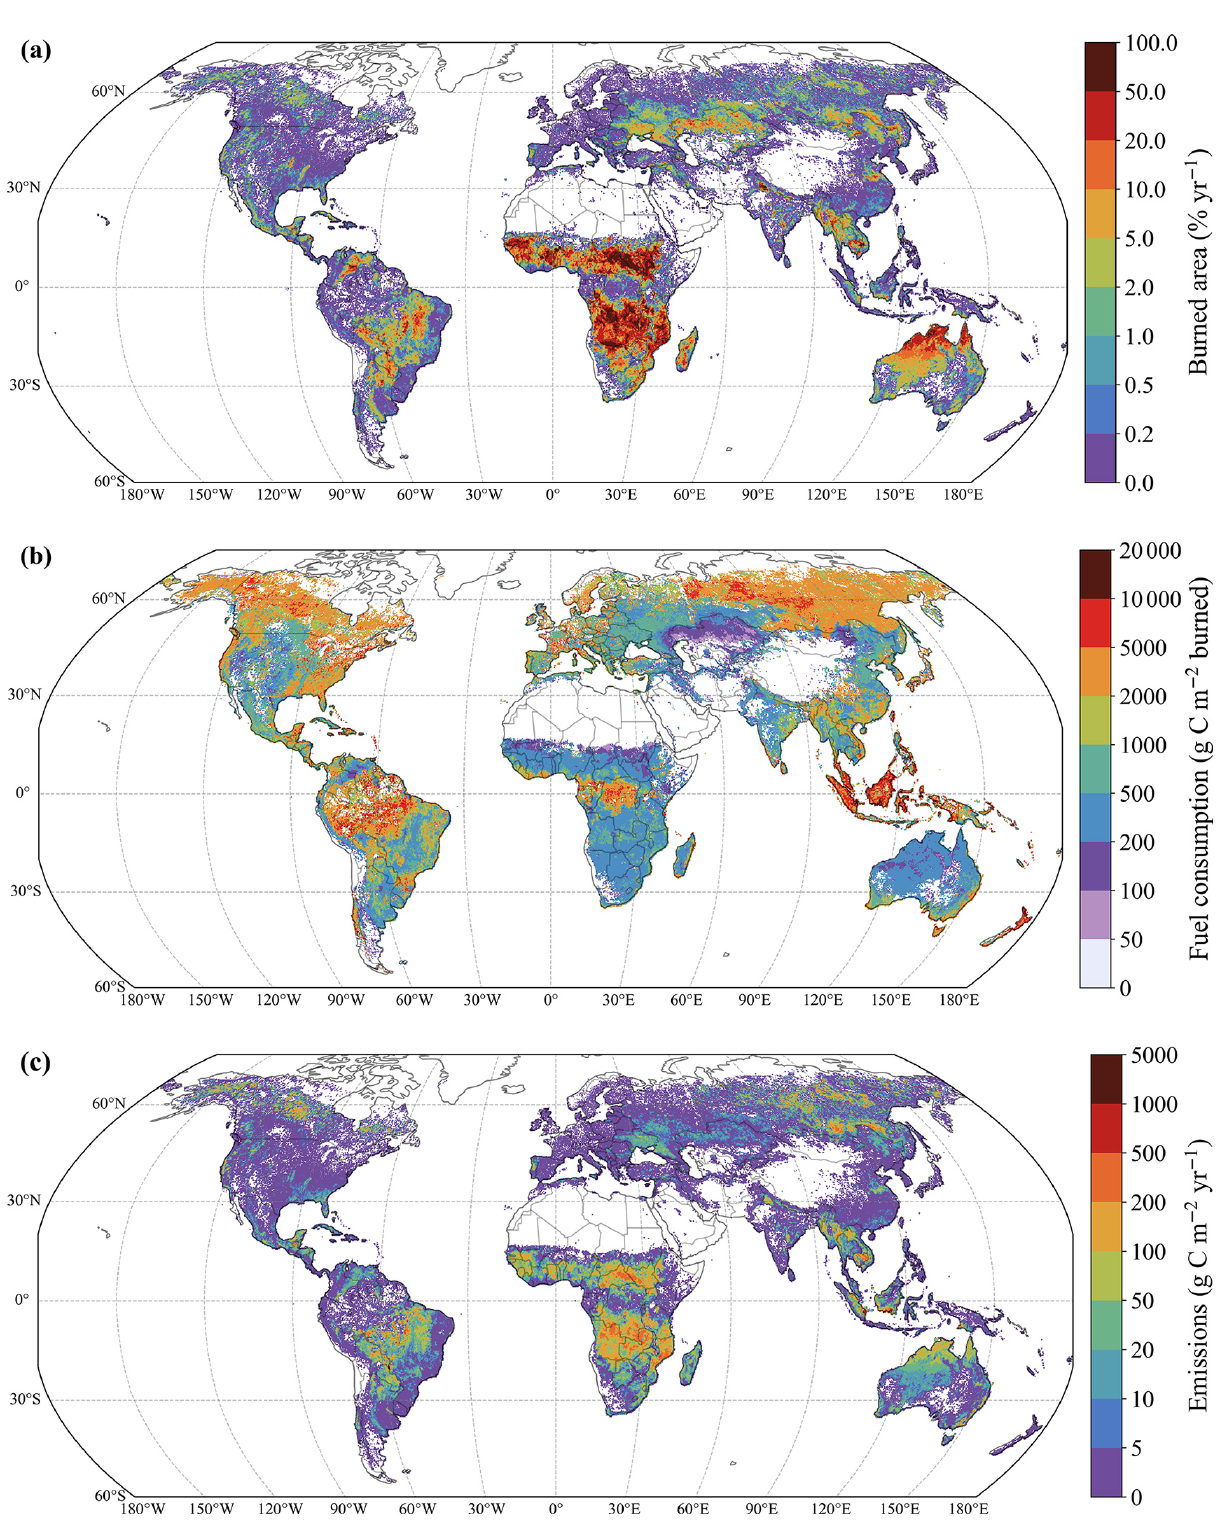
Figure 5. Global annual (a) burned area, (b) fuel consumption, and (c) emissions, averaged over 2002–2020. Burned area displayed in panel (a) is the total burned area derived from combining the MODIS MCD64A1 product and additional fire-related forest loss burned area from active fire detections that overlap forest loss. Maps are aggregated to 0.25 ◦ for